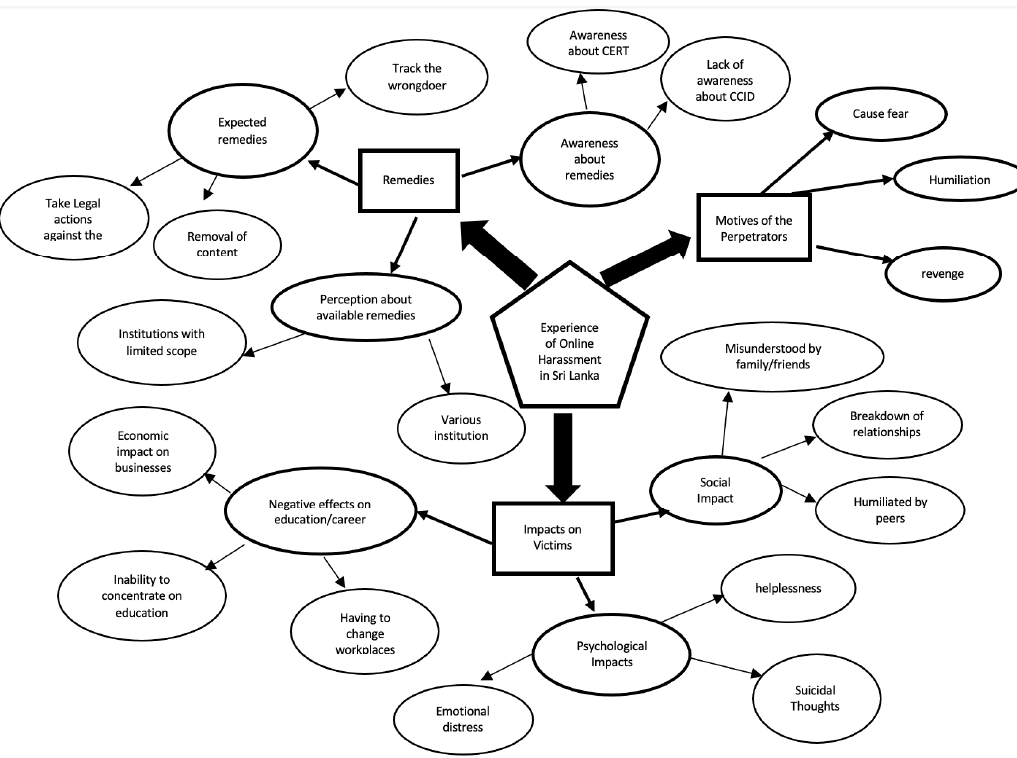
Figure 1. Thematic